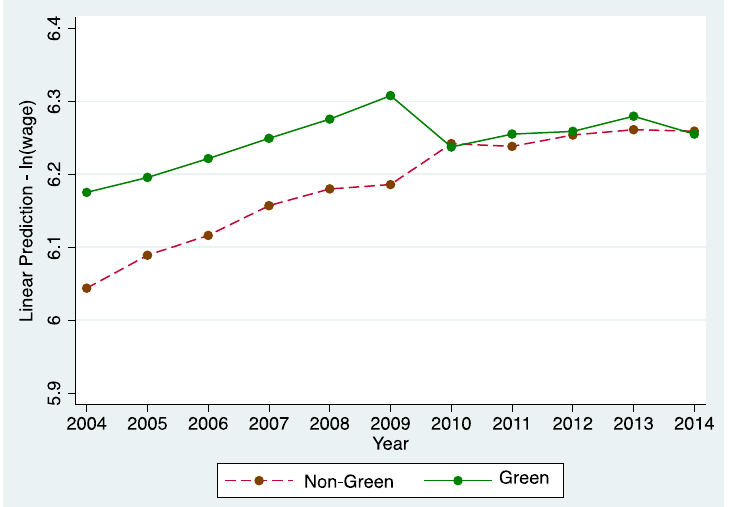
Figure 2. Effect plots for the interaction of the time and green industry